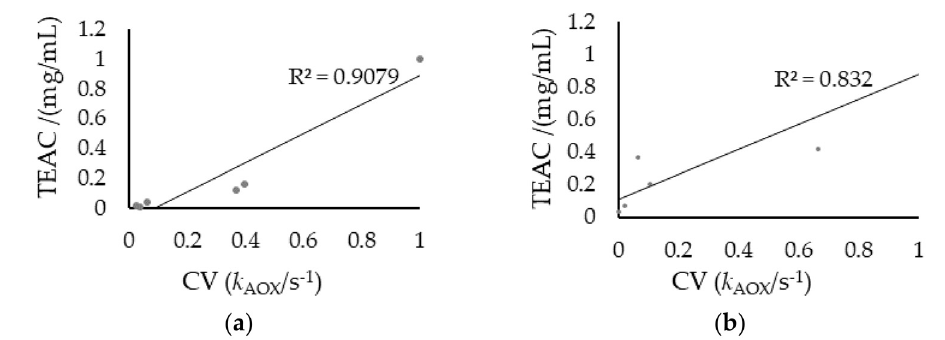
Figure 9. Linear correlation analysis between cyclic voltammetry (CV) and Trolox equivalent an- tioxidant capacity (TEAC) (mg/mL) assay: ( a ) HMV; ( b ) ComV. CV was expressed as CV ( k AOX ), where k AOX (s − 1 ) is the antioxidant capacity constant (or apparent constant); R 2 is the square of linear correlation